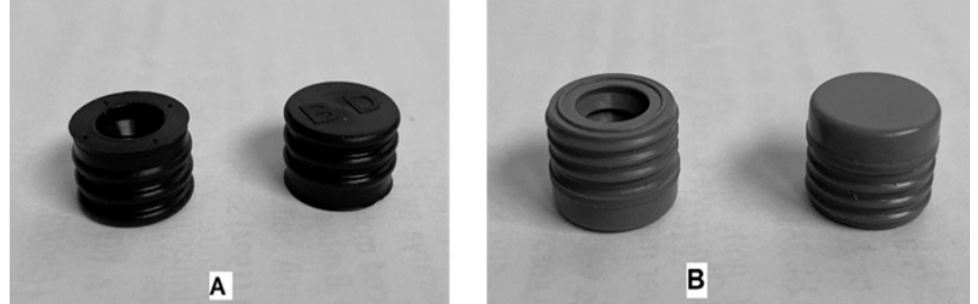
Figure 2. Pictures of the sealing pieces used in this study. Key, elastomer PH 701/50 C BLACK coded as JEA ( A ) and elastomer 4023/50 GRAY coded as JEN ( B ).